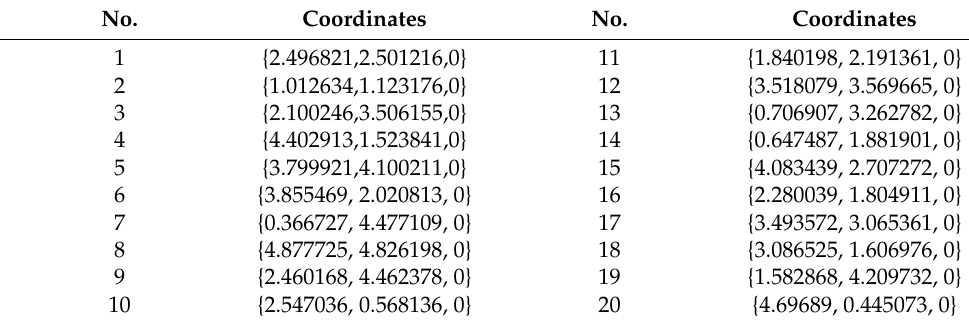
Figure 12. ( a ) Schematic diagram when the rigid body impacts at one of 20 positions; ( b ) Positions of 20 random points. Table 2. Coordinates of 20 random points for impact